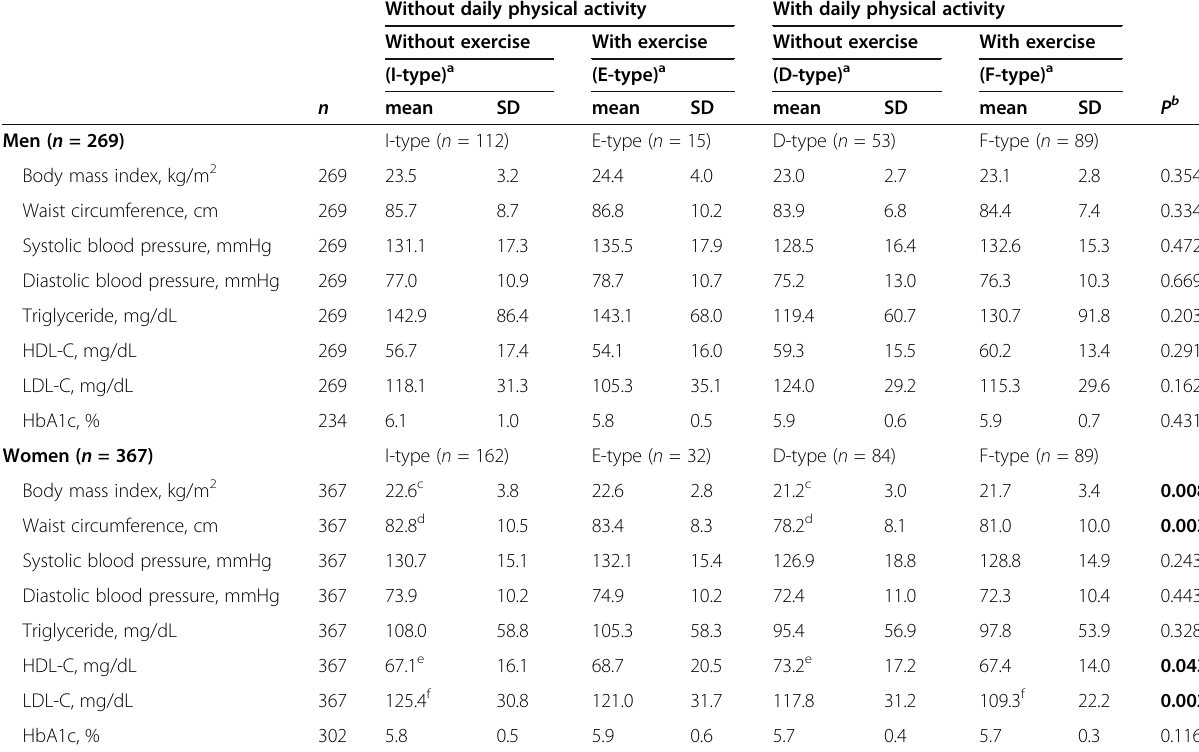
Table 5 Mean differences in the risk factors for metabolic syndrome by physical activity type in sex-stratified analyses Without daily physical